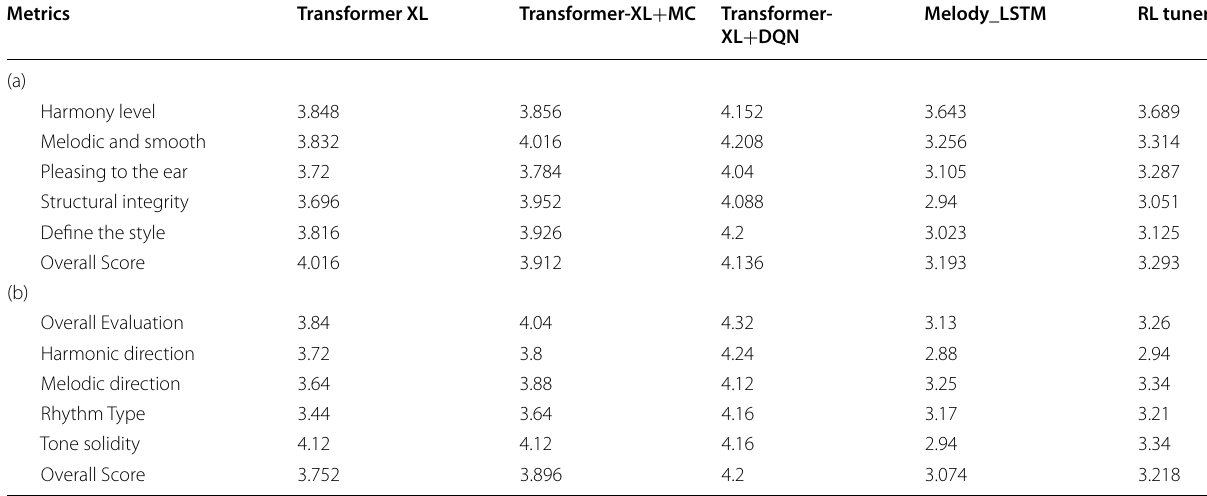
Table 4 Subjective evaluation results of human ear assessment in the (a) non-professional groups and (b) professional groups